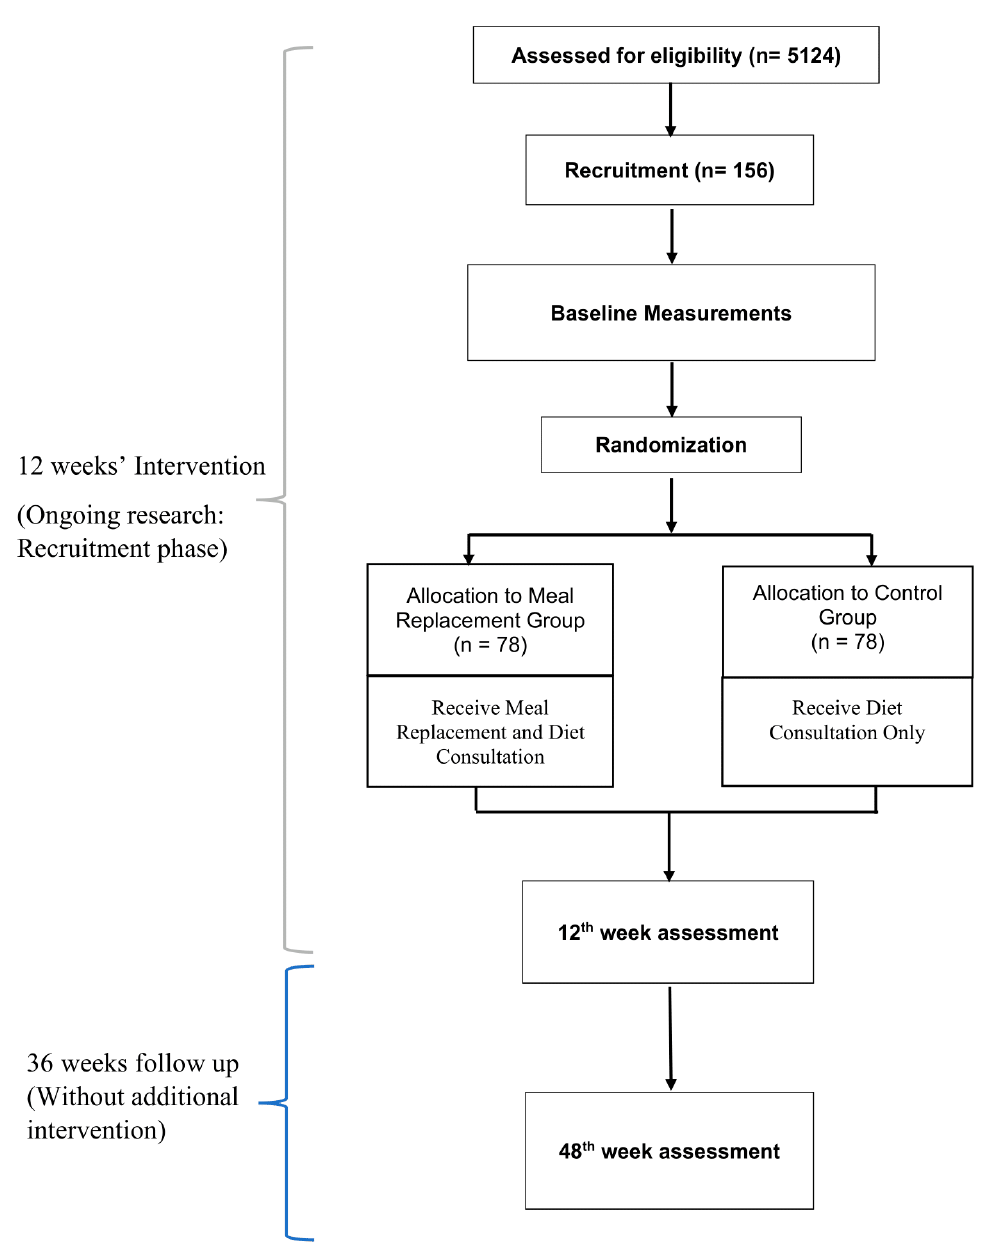
Figure 1. Research Flow Chart.